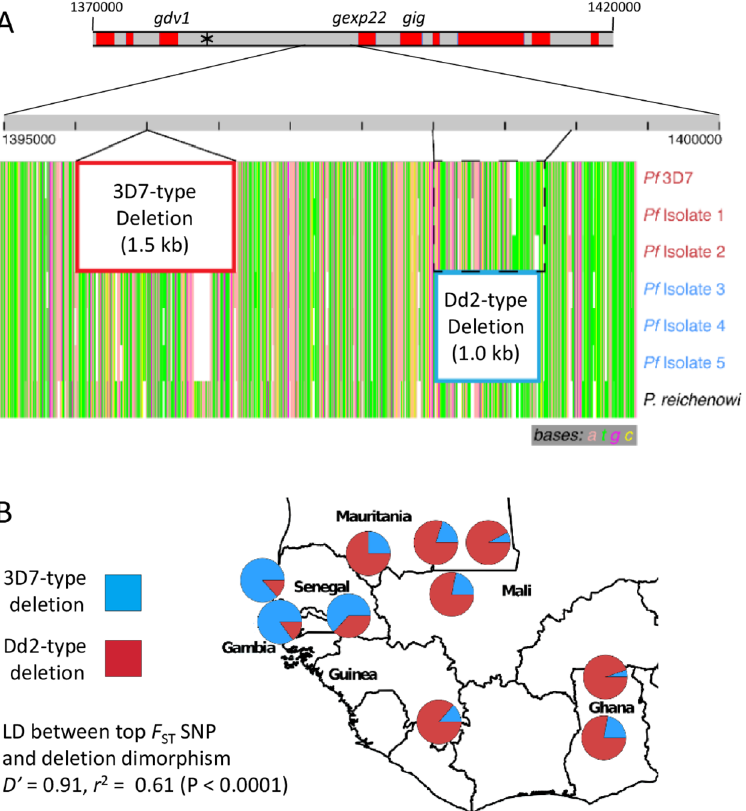
Figure 5. Mutually exclusive large allelic deletions on chromosome 9 within the high F ST window between gdv1 and gexp22 . ( A ) Map of a 60 kb region of the chromosome (from position 1,370,000–1,430,000) marking the individual genes, and zoom into a 5 kb part of the intragenic region of the reference 3D7 sequence. The position of the highest F ST SNP is shown with an asterisk. The PacBio long-read sequence pileup of the region from six P. falciparum isolates shows the two allelic deletion blocks, termed the 3D7 type (1.5 kb deletion outlined in red) and Dd2 type (1 kb deletion in blue). PacBio sequencing of the closely related species P. reichenowi identified the presence of both insert blocks, indicating the deletion event occurred subsequent to the separation of these two species. ( B ) Map showing pie charts of the frequencies of the alternative allelic deletion alleles across West Africa, 3D7 reference type (red) and Dd2 type (blue). Short read data from single genotype infections were mapped to a partial chromosome 9 reference containing both the 3D7 and Dd2 insert types, allowing proportions of alleles to be determined at all except one of the local populations (Faranah in Guinea for which mapped read depths were too low for most isolates). The deletion alleles were in strong overall linkage disequilibrium (LD) with the alleles at the highest F ST SNP ( D ′ = 0.91, r 2 = 0.61), a similar association seen within most of the local populations analysed separately (mean D ′ = 0.93, mean r 2 =